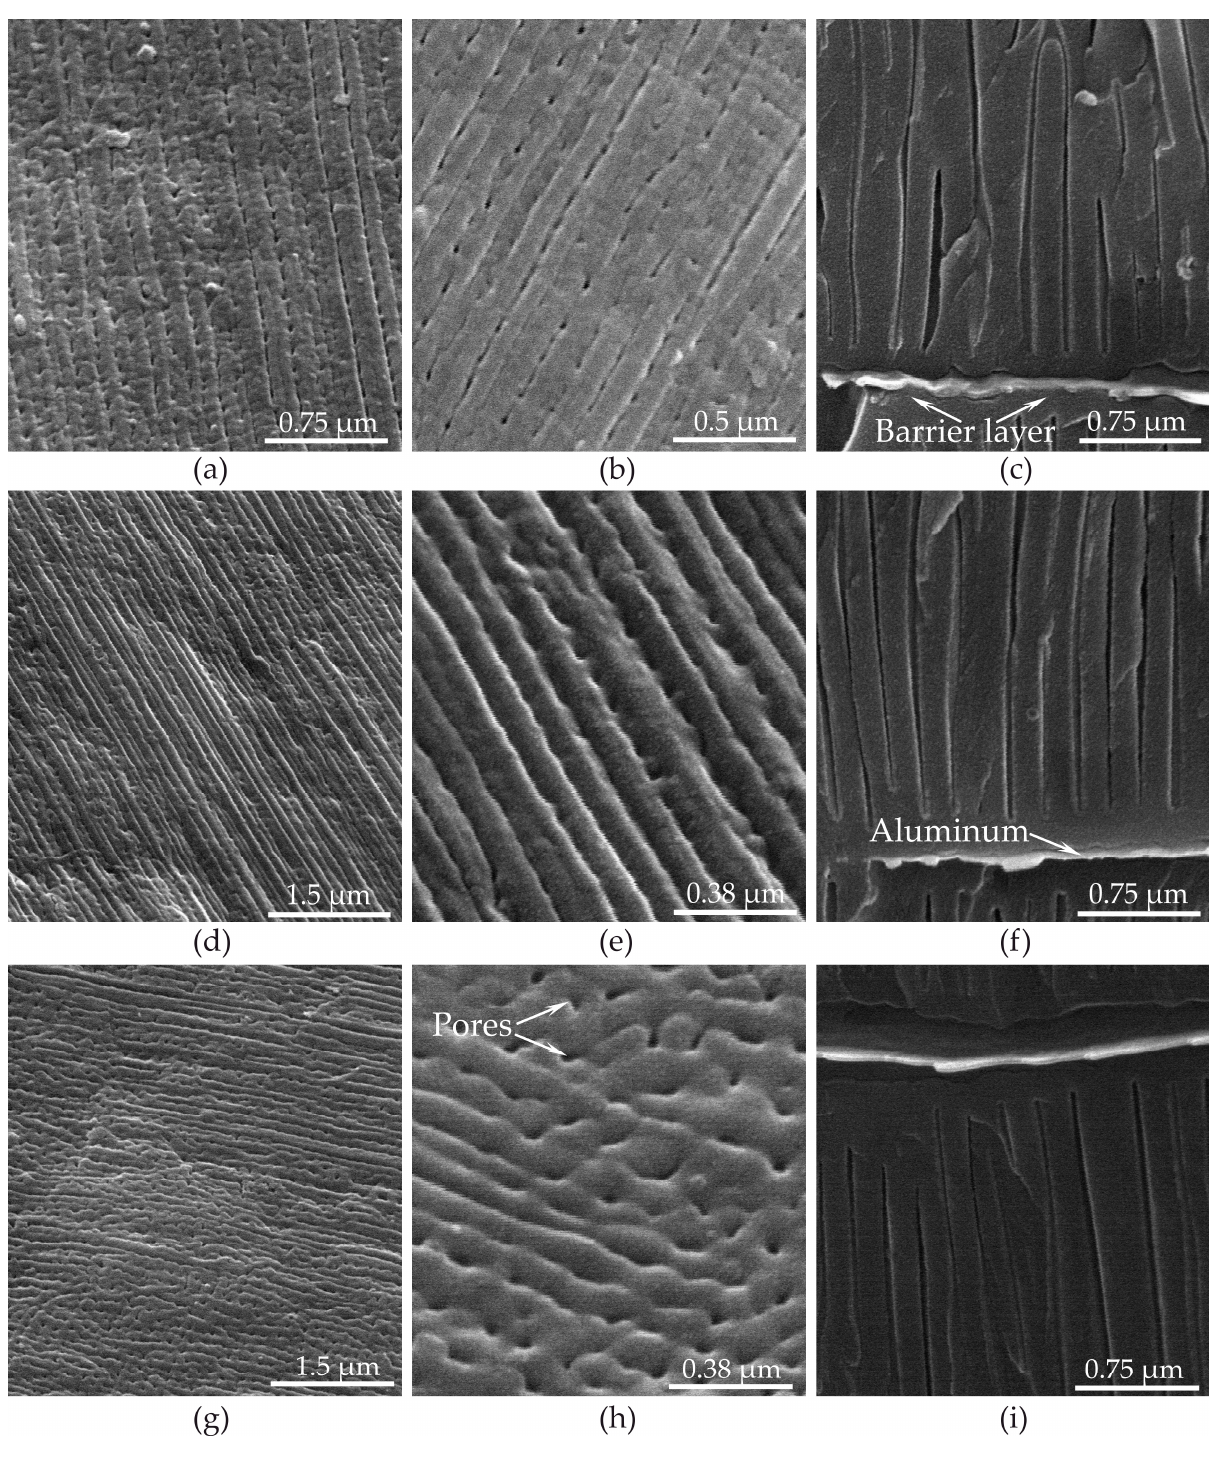
Figure 14. SEM images at various resolutions of porous aluminum oxide film surfaces ( a , b ) and cross-section, ( c ) formed in the galvanostatic mode in 0.6 M malonic acid without arsenazo-I at an anodic current density of 6.0 mA·cm –2 , porous aluminum oxide film surfaces ( d , e ), and cross-section ( f ) formed at an anodic current density of 50 mA·cm –2 . Porous aluminum oxide film surfaces ( g , h ) and cross-section ( i ) formed at anodic current density of 500 mA·cm –2 .